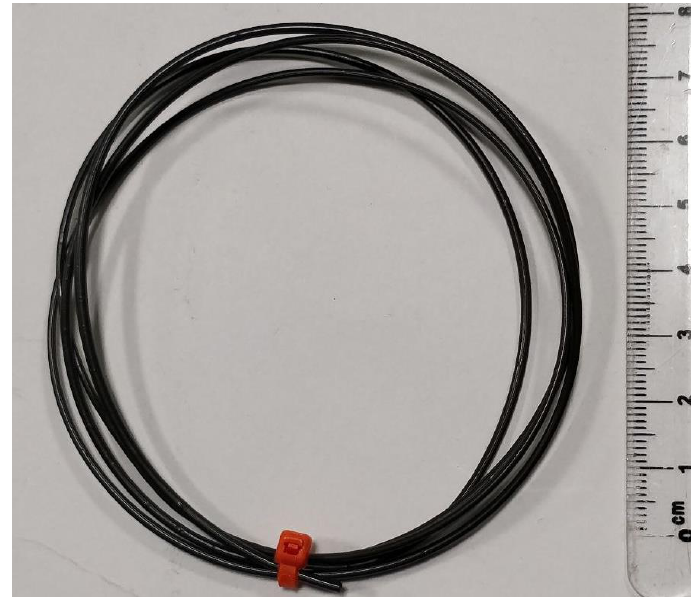
Figure 2. Photo of the 10CFO/PLA magnetic composite